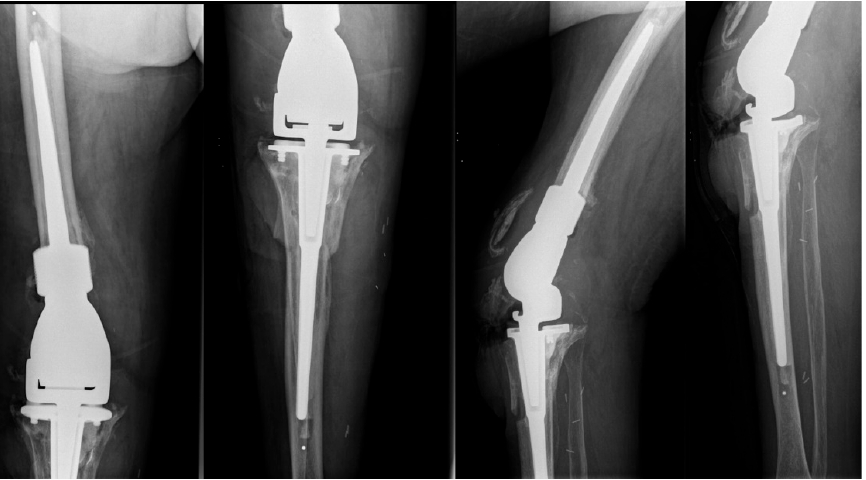
Figure 1. Anteroposterior and lateral X-ray views of the revised arthroplasty, which was performed prior to the patient’s presentation in the outpatient clinic.